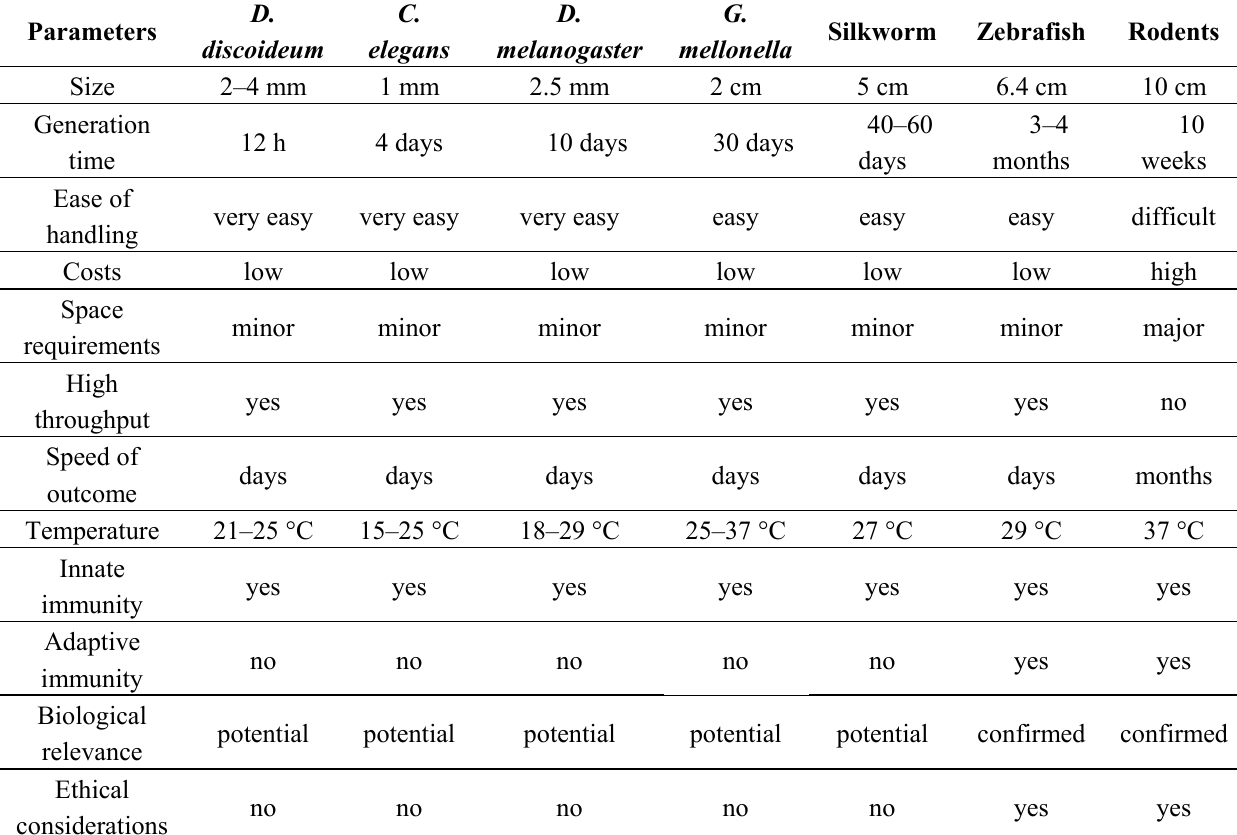
Table 1. Comparison of the infection models available for Pseudomonas pathogenicity studies.